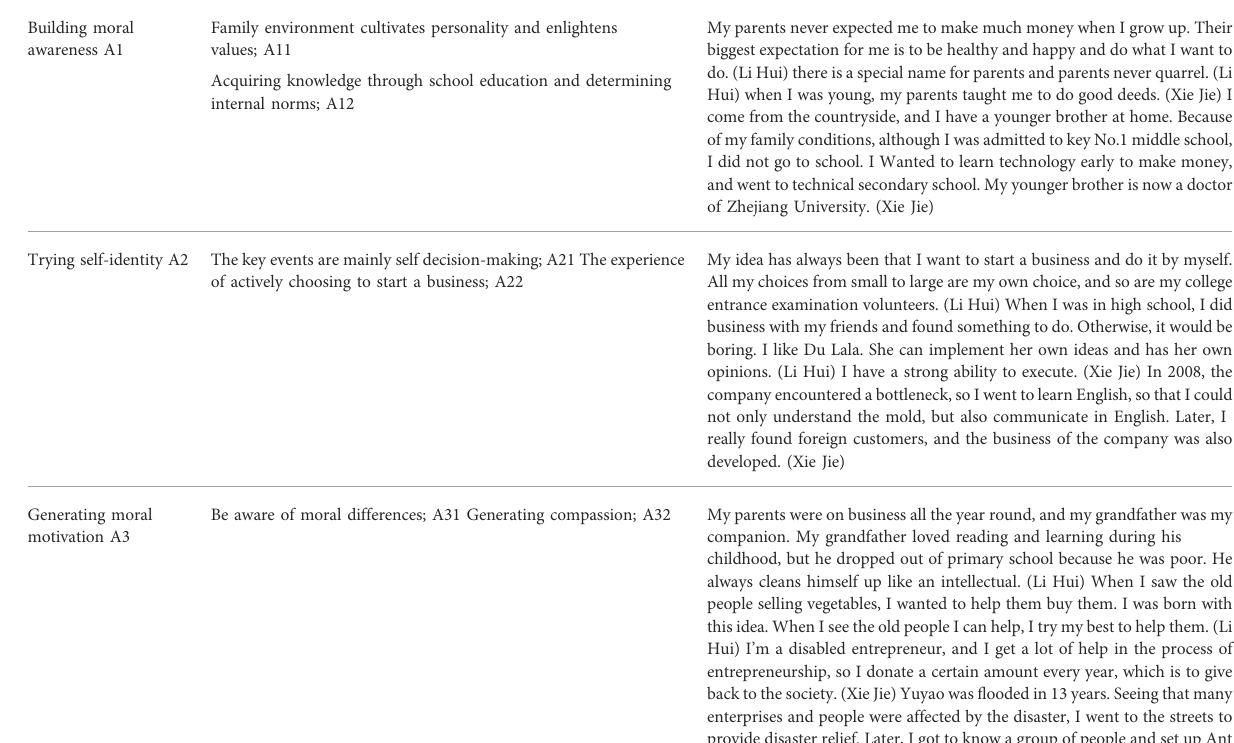
TABLE 3 Examples of typical statements and related categories in the stage of concept